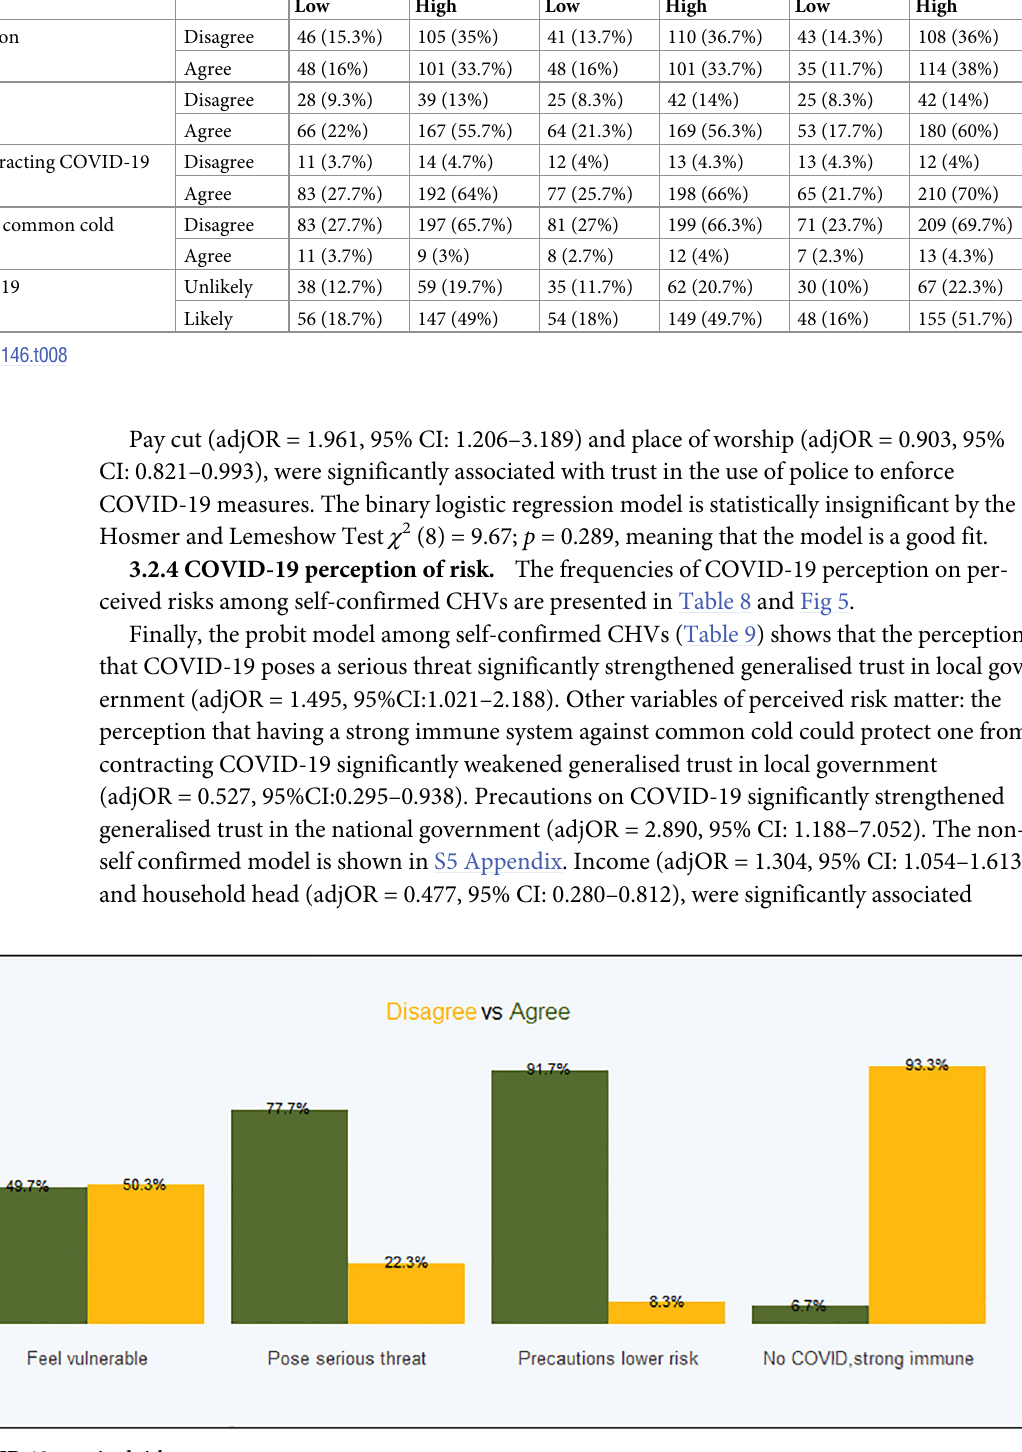
Fig 5. Overall COVID-19 perceived